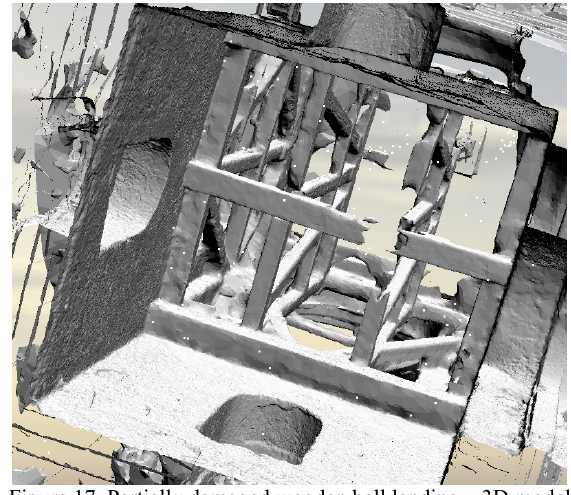
Figure 17. Partially damaged wooden bell landing – 3D model